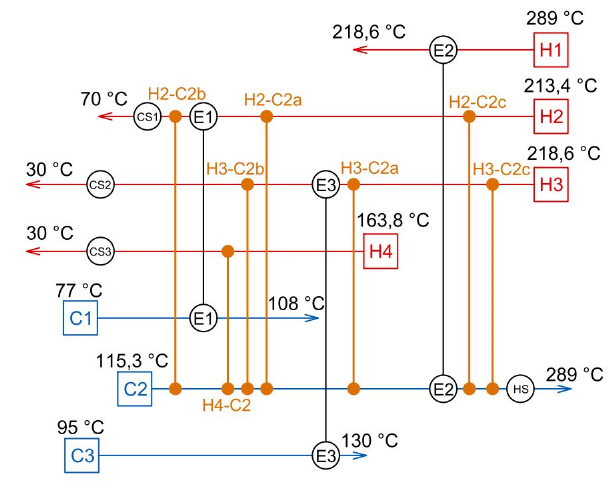
Figure 6. The Retrofit Superstructure Grid Diagram (RSGD) of the studied process.